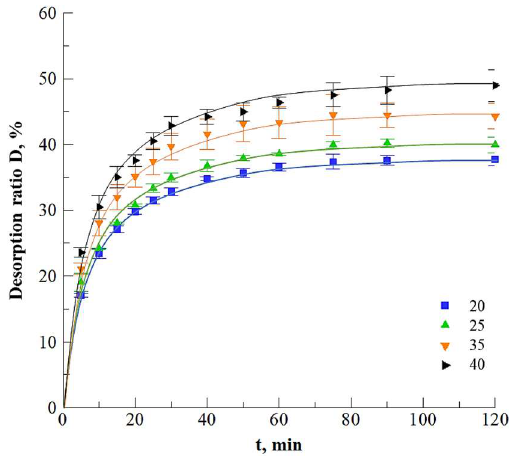
Figure 11. Influence of salt concentration on the desorption ratio of sinigrin with KCl and NaCl solutions at 30 ◦ C and 300 rpm for 90 min (static mode of desorption). solutions at 30 °C and 300 rpm for 90 min (static mode of desorption).